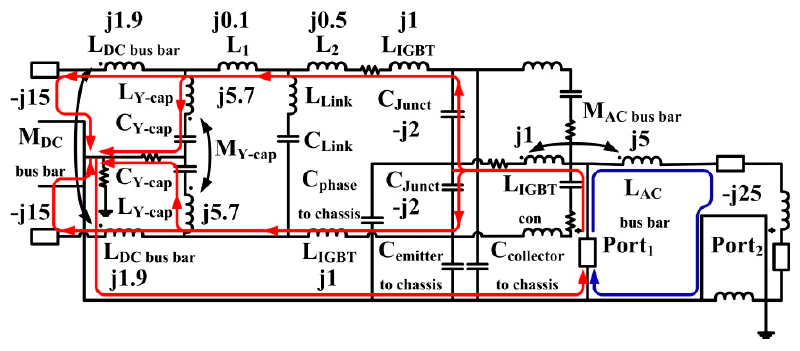
Figure 5. Current ‐ following path at 6 MHz.